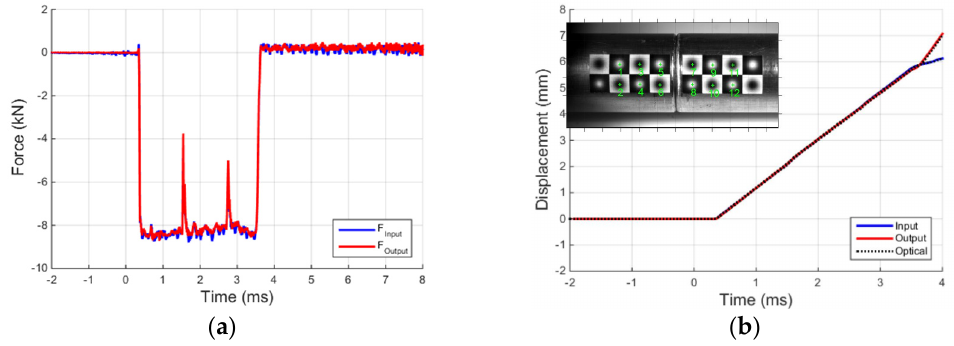
Figure 6. ( a ) Equilibrium check at input ‐ output bar interface; and ( b ) comparison between displacements obtained with Hopkinson bar theory and with the fast tracking optical algorithm .